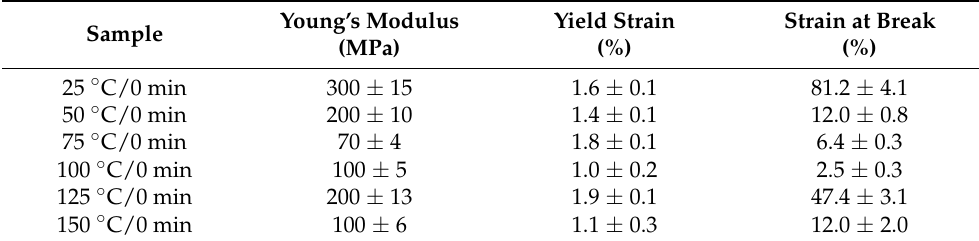
Table 4. Young’s modulus, yielding strain and strain at break of representative PVDF membranes as a function of dissolution temperature.